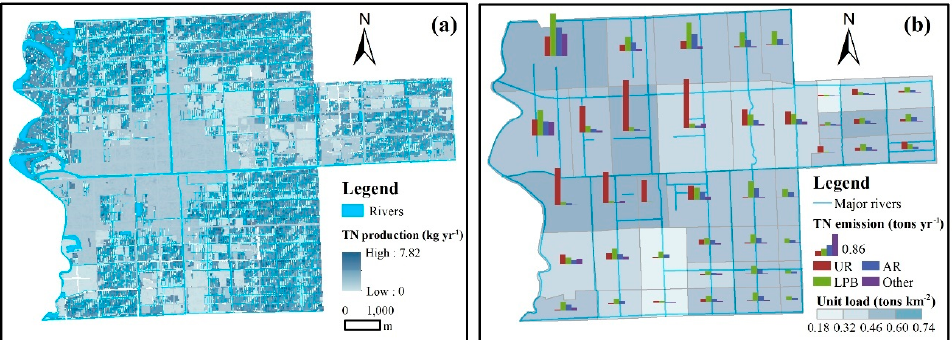
Figure 7. Annual average NPS TN load production per grid ( a ) and emissions into the river in each sub-basin ( b ).